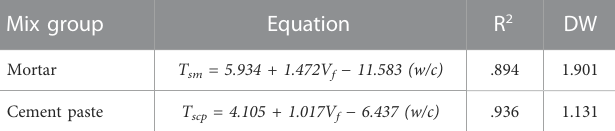
TABLE 8 Proposed tensile-strength equations for mortar and cement paste against PP, V f, and w/c ranging from .3 to .5 Mix group